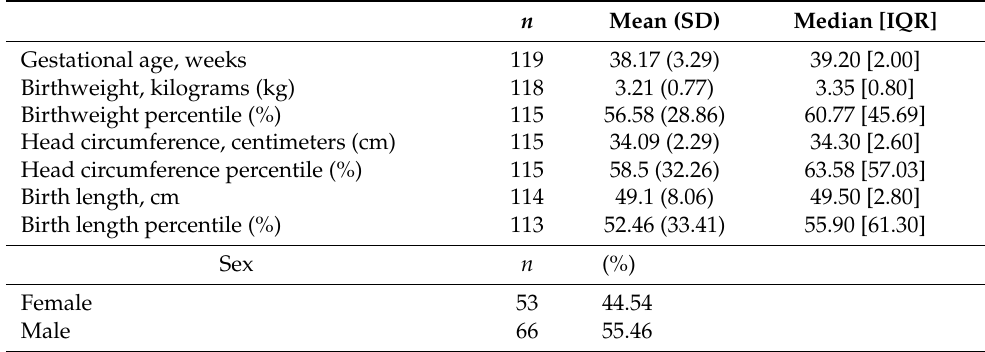
Table 3. Infant baseline characteristics.